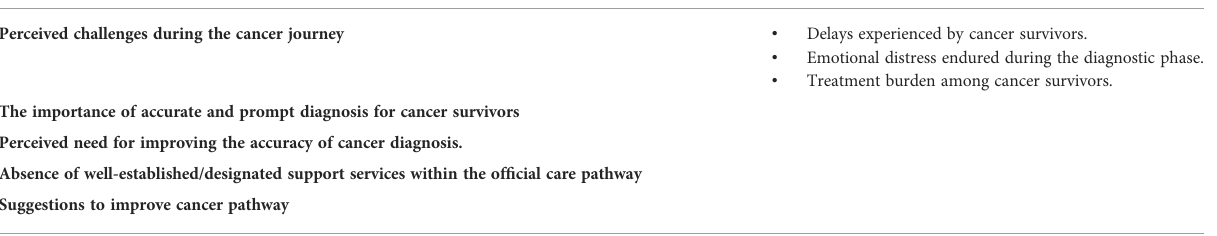
TABLE 2 Emergent themes and subthemes from cancer survivors ’